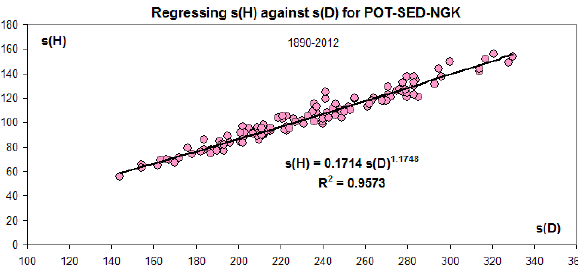
Figure A1. The average s(H) for each year is plotted against the average s(D) for that year. The data can be fitted to a power law as shown, which “explains” 96% of the correlation. We use power laws because most regression plots show somewhat curved point clouds (“rivers” is probably a more descriptive term).